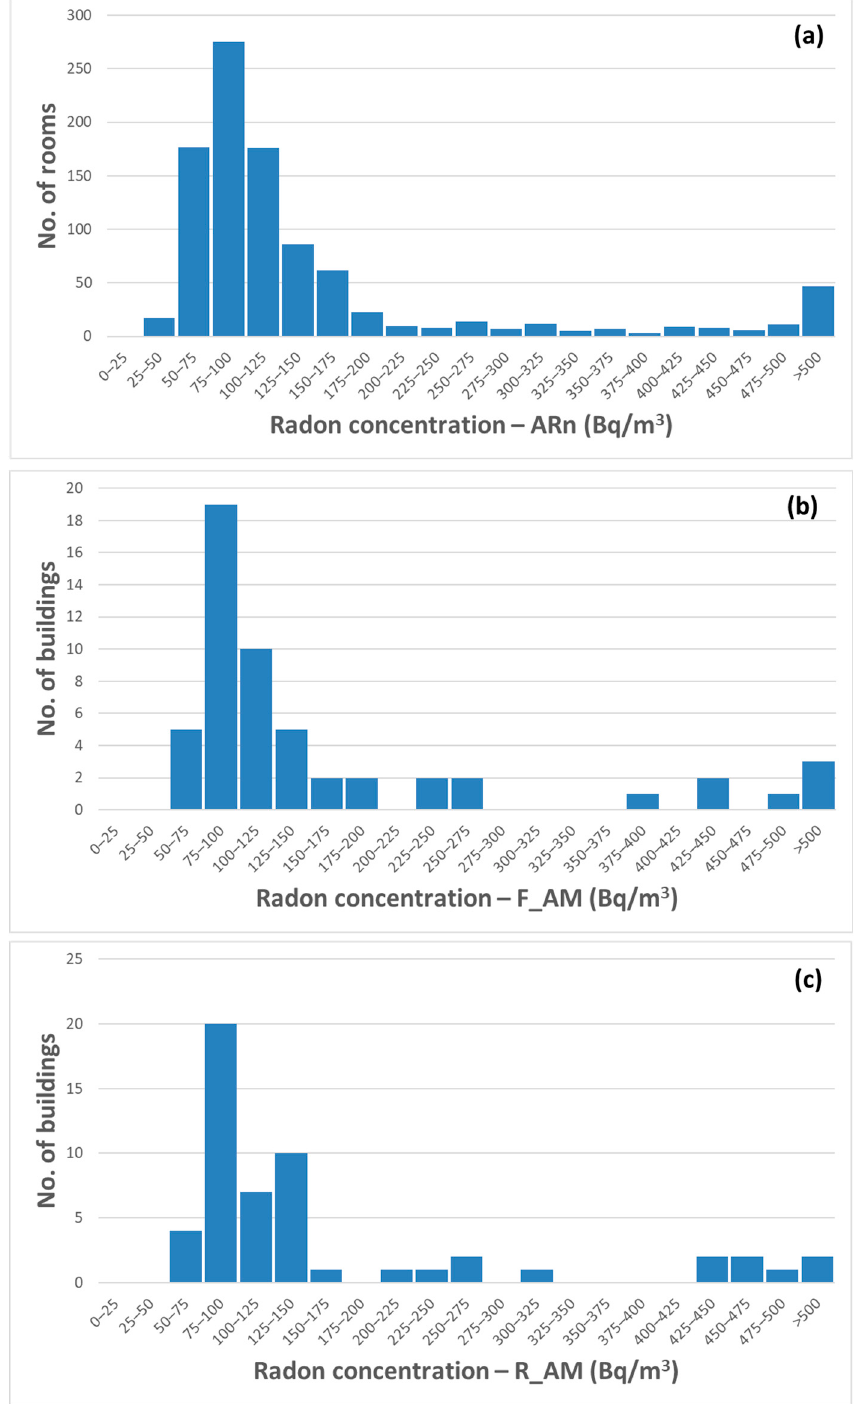
Figure 2. Frequency distribution of ( a ) ARn values in all 963 rooms, ( b ) F_AM values in all 54 buildings (concentration calculated as average of floor means), and ( c ) R_AM values in all 54 buildings (concentration calculated as average of all room concentration values).